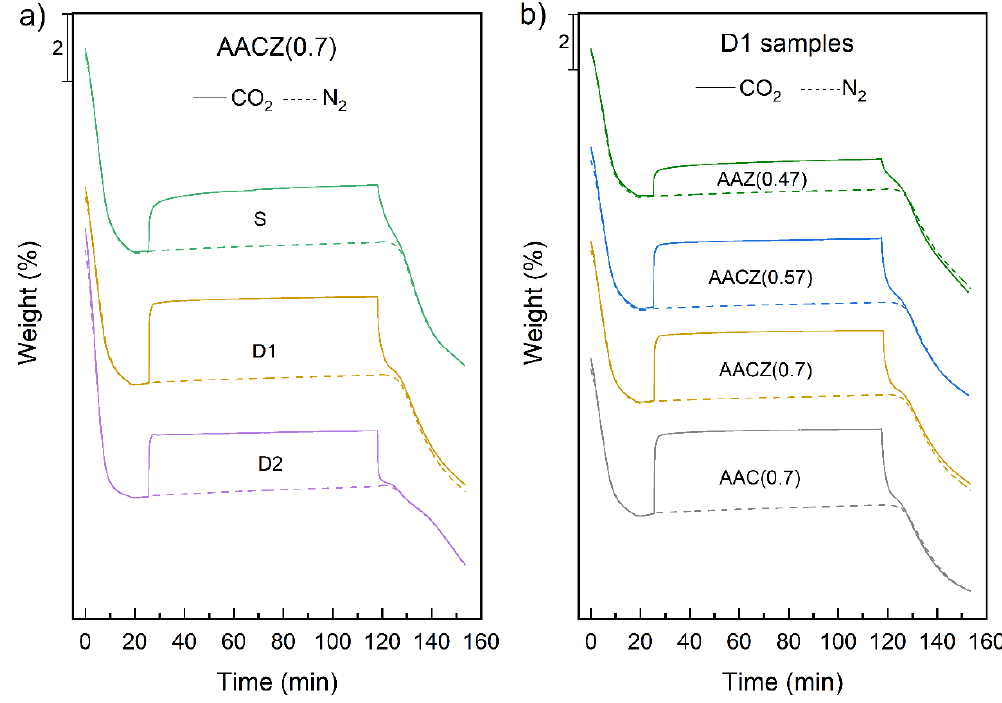
Figure 9. Thermogravimetric records of CO ₂ and N ₂ sorption of AACZ (0.7) ( a ) and D1 samples ( b ).